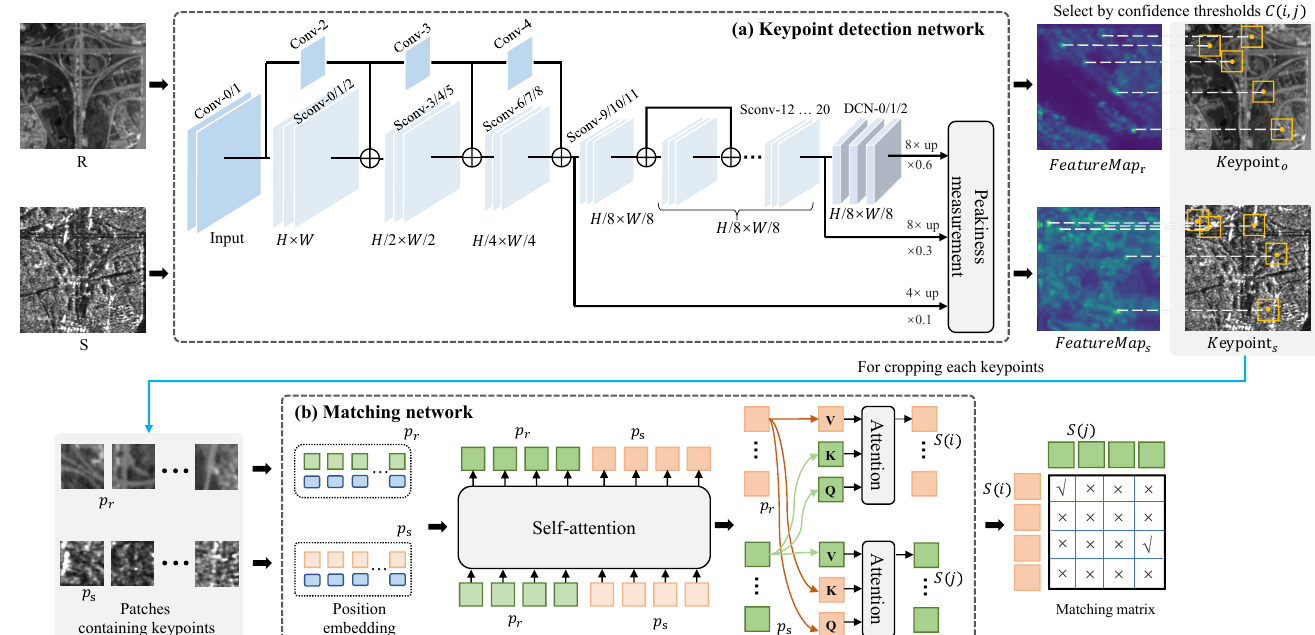
Figure 1. Flowchart of the multimodal remote sensing image matching framework. ( a ) Keypoint detection network. The detection network parameterizes the multimodal remote sensing image ( R and S ) and calculates the responses for keypoints from three scales to generate the keypoint feature maps ( FeatureMap r and FeatureMap s ). ( b ) Matching network. The matching network performs global interaction fusion of all patches cropped from keypoint o and keypoint s , which is used to obtain similarity feature descriptions ( S ( i ) and S ( j ) ) with cross-modal matching. The matching matrix is used to describe the matching correspondence of all candidate